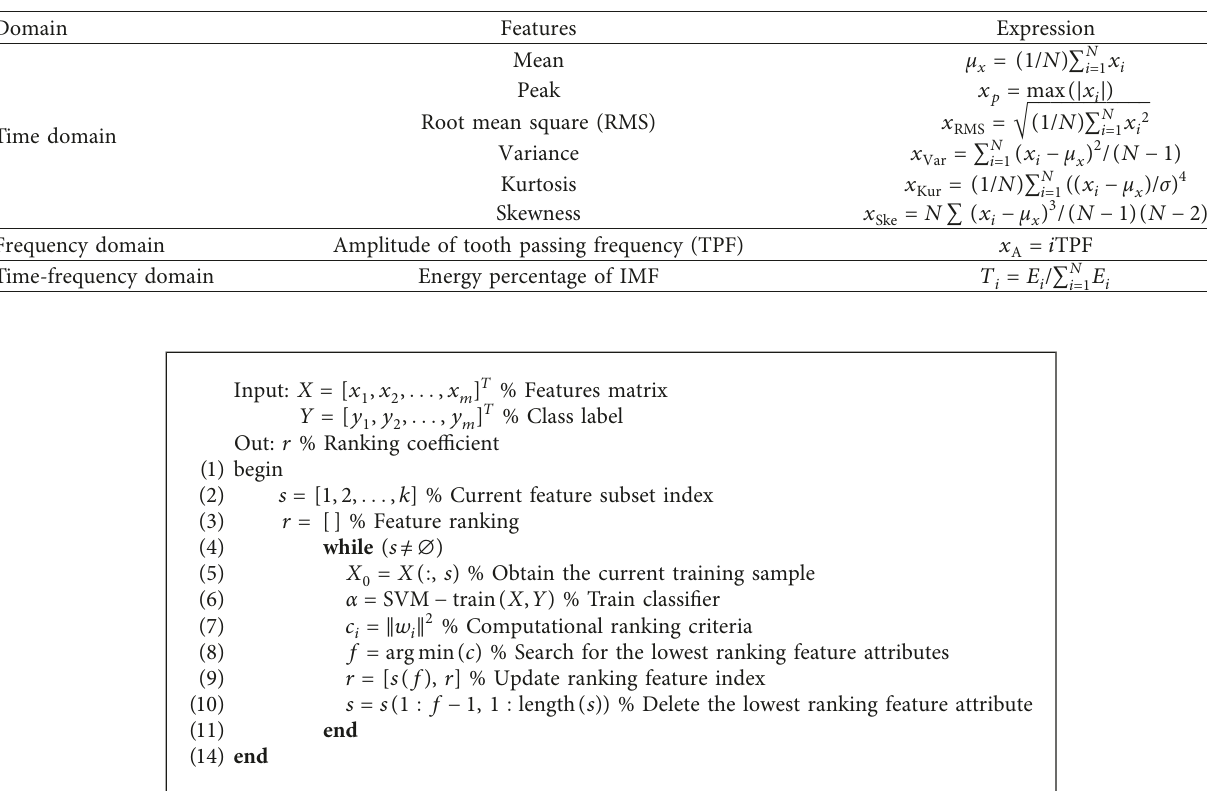
A LGORITHM 1: Description of the SVM-RFE